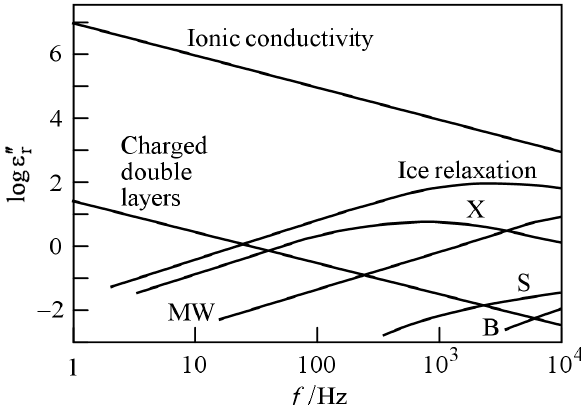
Figure 1. Contributions to the imaginary part ε (cid:48)(cid:48) r = ε (cid:48)(cid:48) / ε 0 of the relative permittivity of soil (after [14]). B: bound water relaxation; MW: Maxwell–Wagner effect; S: surface conductivity; X: crystal water relaxation.